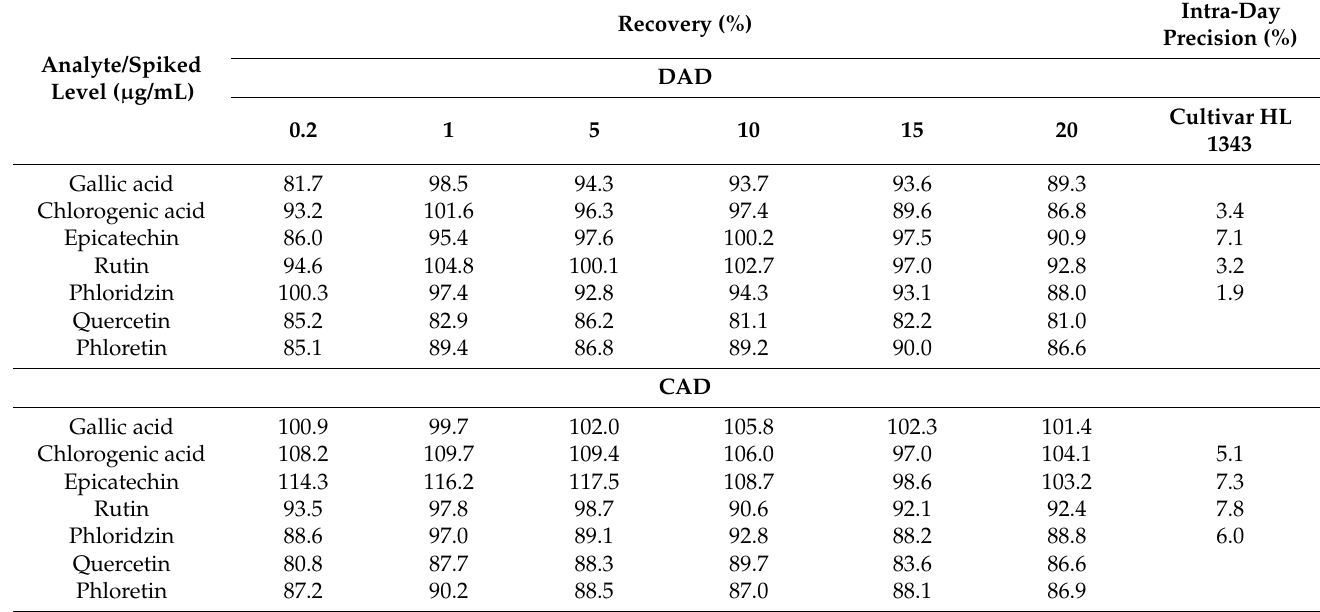
Table 3. The accuracy of method expressed in terms of compound recovery at six concentration levels using samples Scheme 0.2; 1; 5; 10; 15 and 20 µ g/mL), and intra-day precision. Separation conditions: gradient elution with mobile phases aqueous acetic acid with pH 2.8 (A) and acetonitrile (B), gradient profile 10–50% B in 10 min, 50% B 0.2 min, 50–10% B in 2.3 min, column temperature 30 ◦ C, injection volume 10 µ L, flow rate 1.0